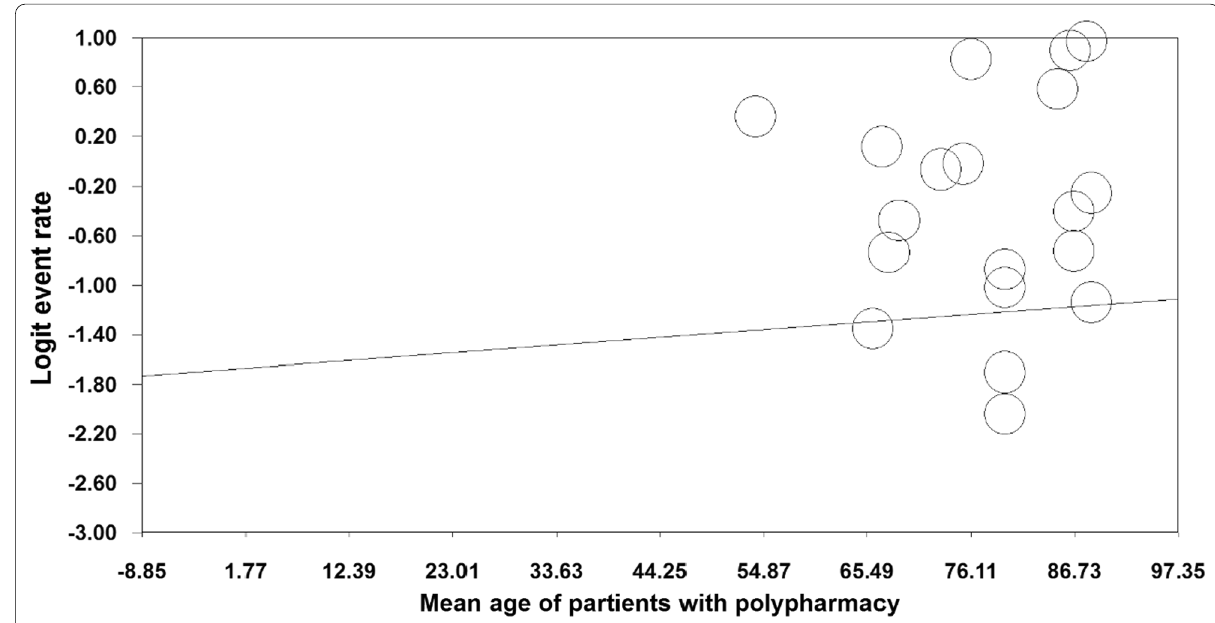
Fig. 6 Meta‑regression diagram of the prevalence of polypharmacy in patients with COVID‑19 by age of study participants